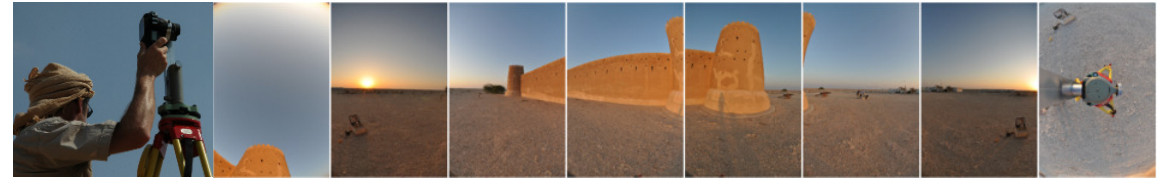
Figure 5: Camera Nikon D90 at the nodal point adapter in use (left) and eight of nine panorama images (right)